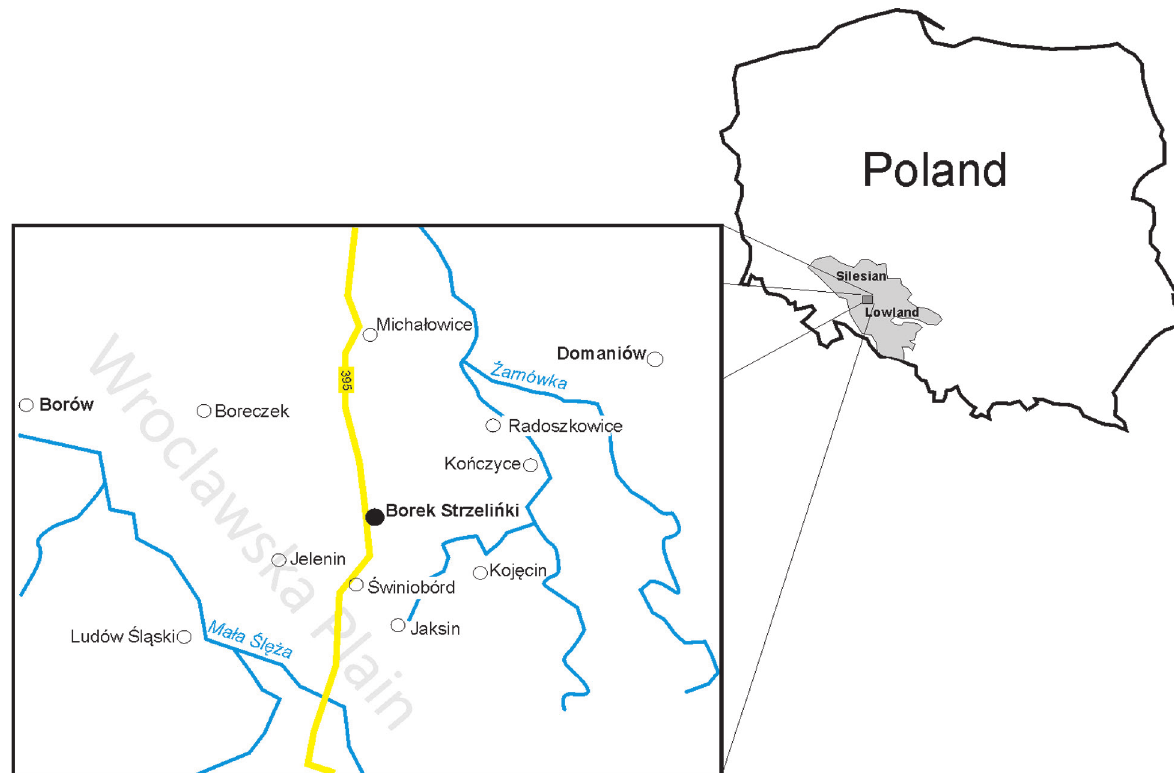
Fig. 1. Location of Borek Strzeliński against the background of the region and Poland. Source: J.